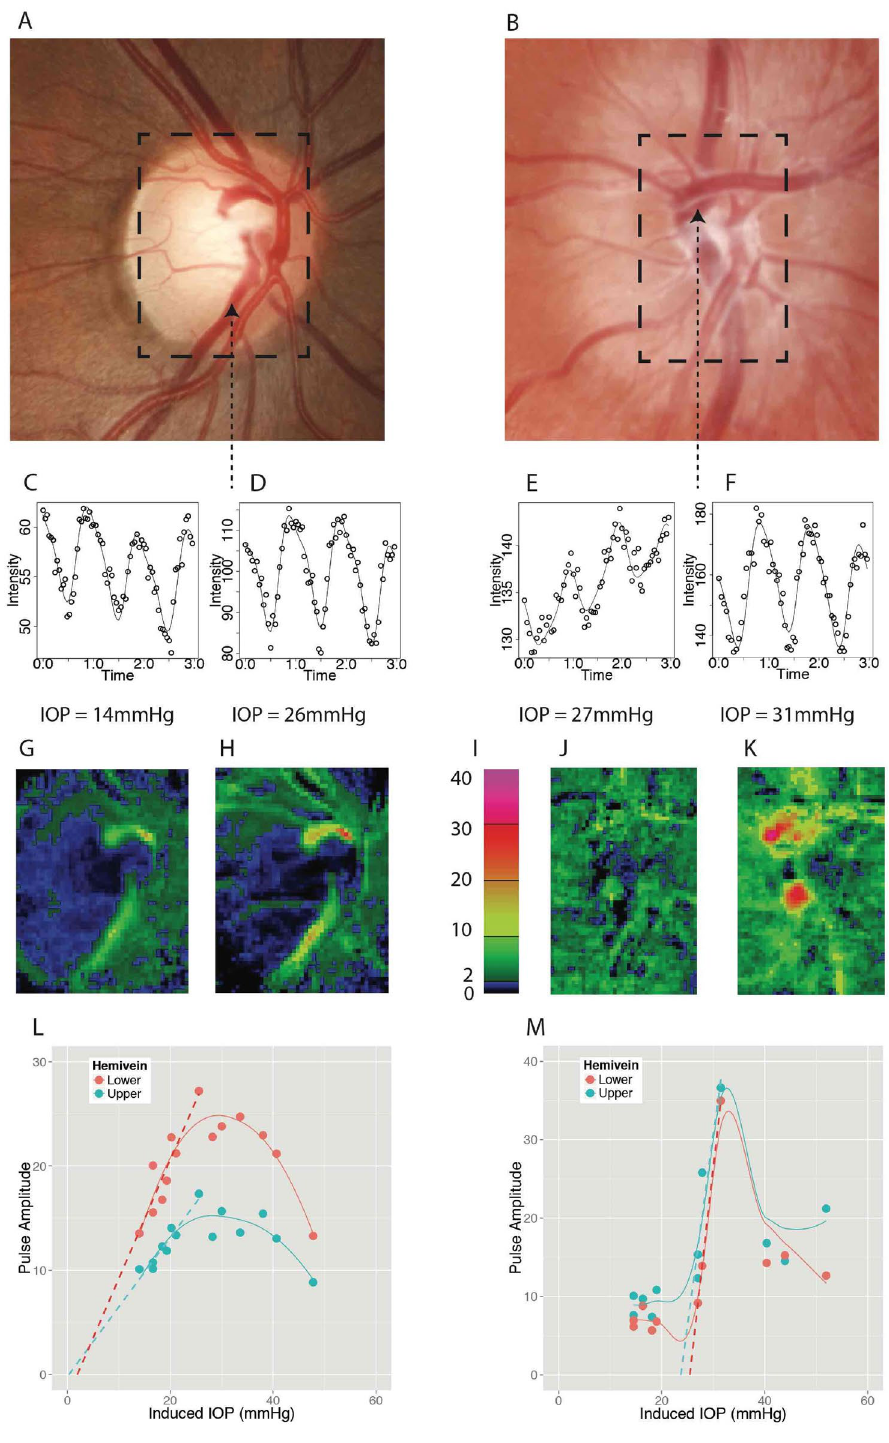
Figure 1. Schematic diagram explaining the analytical process of estimating ICP. Optic disk photographs of normal (7 mmHg, A ) and elevated ICP (31 mmHg, B ) eyes. The region of analytical interest (ROI) is shown in the dashed rectangles. Papilloedema can be seen in ( B ). Two harmonic curve fits are applied to data from all locations across the entire ROI with examples from one location at specified IOP shown in the inferior hemivein in ( C ) and ( D ) and superior hemivein in ( E ) and ( F ) (arrows). These locations were the sites of maximal pulse amplitude for the respective vessels. The pulse amplitudes in arbitrary units are calculated and mapped to the specified IOP to correspond with the ROI ( G , H , J , K ) using a false colour scale ( I ). The maximum pulse amplitude values from the upper and lower hemiveins are chosen automatically from the retinal hemiveins using the map and compared against induced IOP ( L , M ). Linear regression is applied to the rising part of the curve and extrapolated back through the x-axis coinciding with zero pulsation (dashed lines). This value becomes the estimated ICP in mmHg. In ( L ) it is 1 mmHg in erect posture equivalent to 11 mmHg in lateral decubitus. In ( M ) it is 24 mmHg erect posture equivalent to 34 mmHg lateral decubitus. The general shape of the curve can be seen from the locally weighted fit (solid